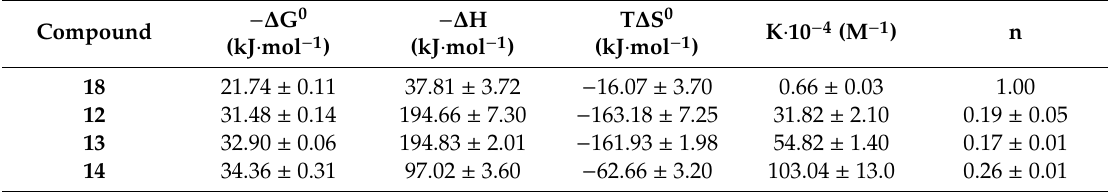
Figure 3. Representative titration of galectin-3 (Gal-3) (40.58 µM) with compound 13 (0.514 mM) in 20 mM phosphate buffer at pH 7.2 with 150 mM NaCl at 25 °C. The top panel shows the raw calorimetric data for 25 automatic injections, 5 µL each (1 µL for the first) of 13 . The area under each peak represents the amount of heat released upon binding of the conjugate to the lectin. The smooth solid lines ( bottom panel ) represent the best fit of the experimental data to a model of n equal and independent sites. Table 2. Thermodynamic parameters for compounds 12 – 14 and 18 obtained by isothermal titration calorimetry in 20 mM phosphate buffer at pH 7.2 with 150 mM NaCl at 25 °C.